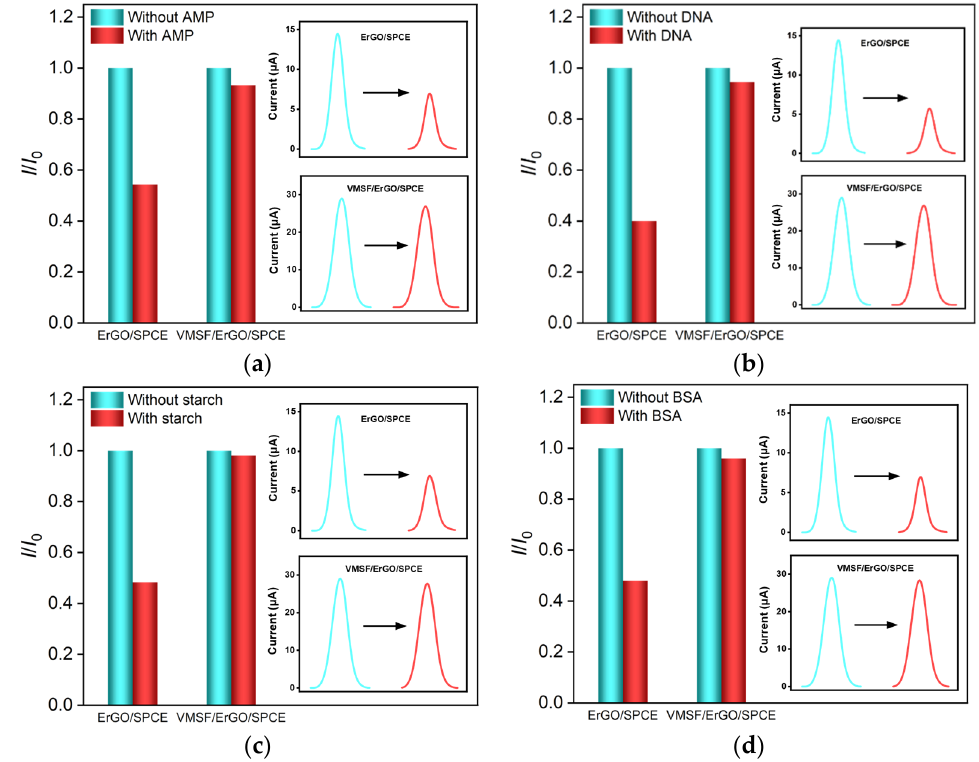
Figure 7. The peak current ratio ( I / I 0 ) of DOX (10 μ M) for the ErGO/SPCE or VMSF/ErGO/SPCE in PBS (0.1 M, pH = 6) with ( I ) or without ( I 0 ) 10 μ g/mL ( a ) AMP, ( b ) DNA, ( c ) starch, or ( d ) BSA. The insets are the corresponding DPV curves obtained for the ErGO/SPCE and VMSF/ErGO/SPCE in the absence (green curve) or presence (red curve) of fouling species. Table 2. Determination of DOX in diluted human serum and urine a . Sample Added ( μ M) Found ( μ M) RSD (%) Recovery (%) 0.0100 Human serum